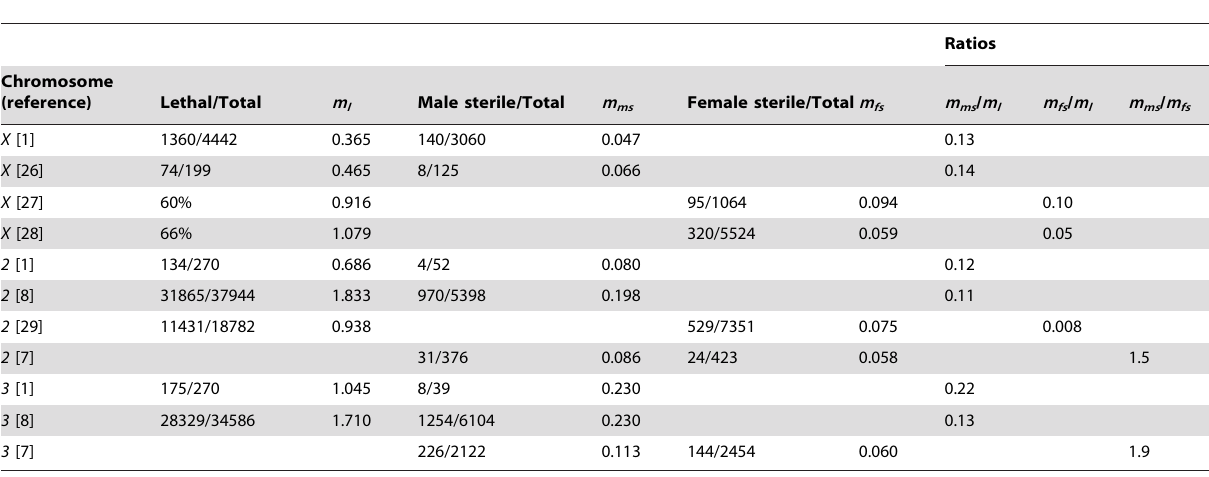
Table 6. Relative frequencies of lethal and sterile mutations after EMS mutagenesis.